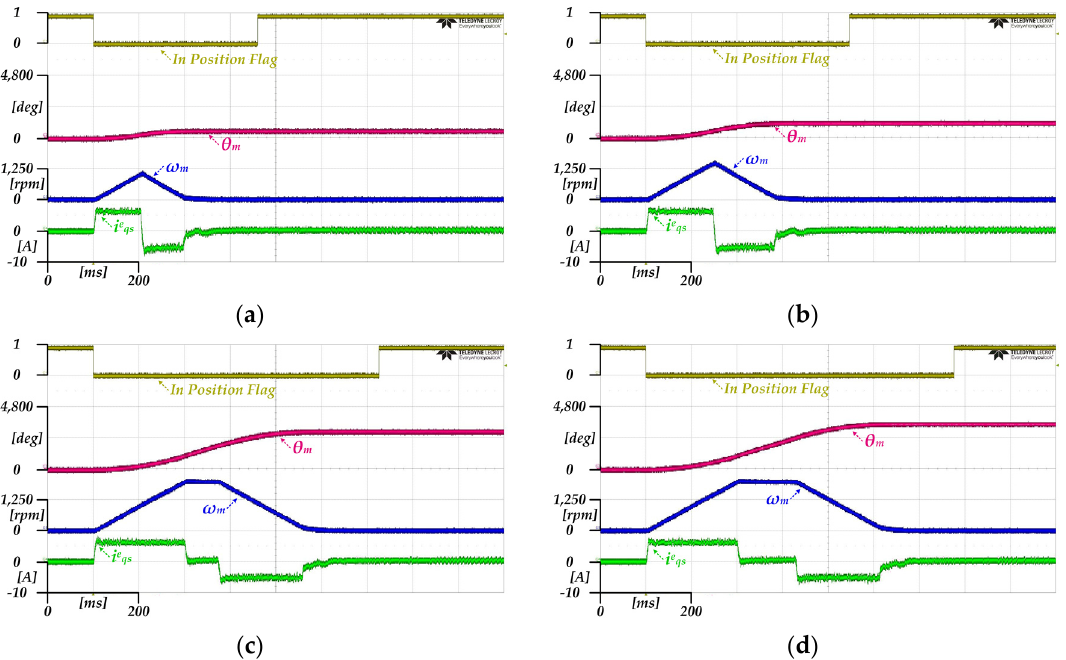
Figure 11. Position, velocity and q-axis current of the proposed method under the overdamping condition ( a ) 600 [deg] position reference; ( b ) 1200 [deg] position reference; ( c ) 3000 [deg] position reference; ( d ) 3600 [deg] position reference.